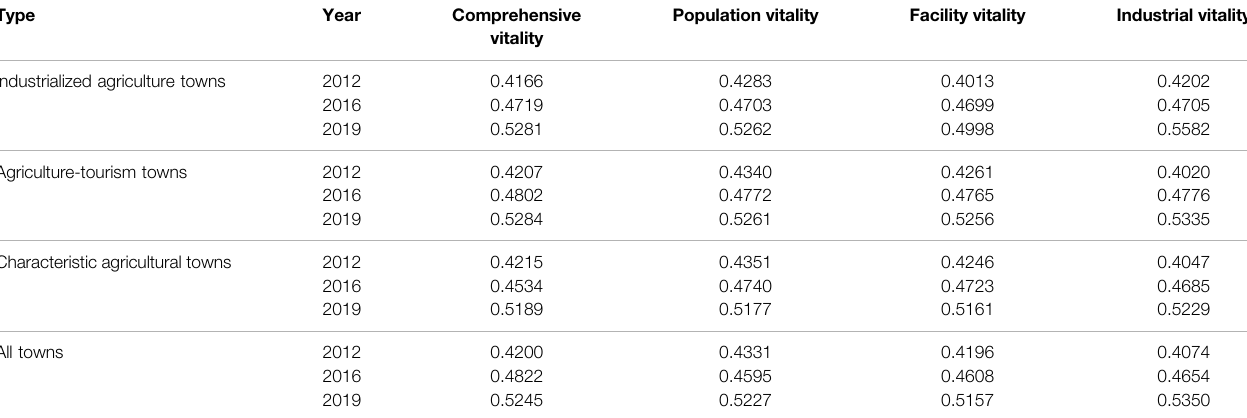
TABLE 3 | Vitality scores of different village types from 2012 to